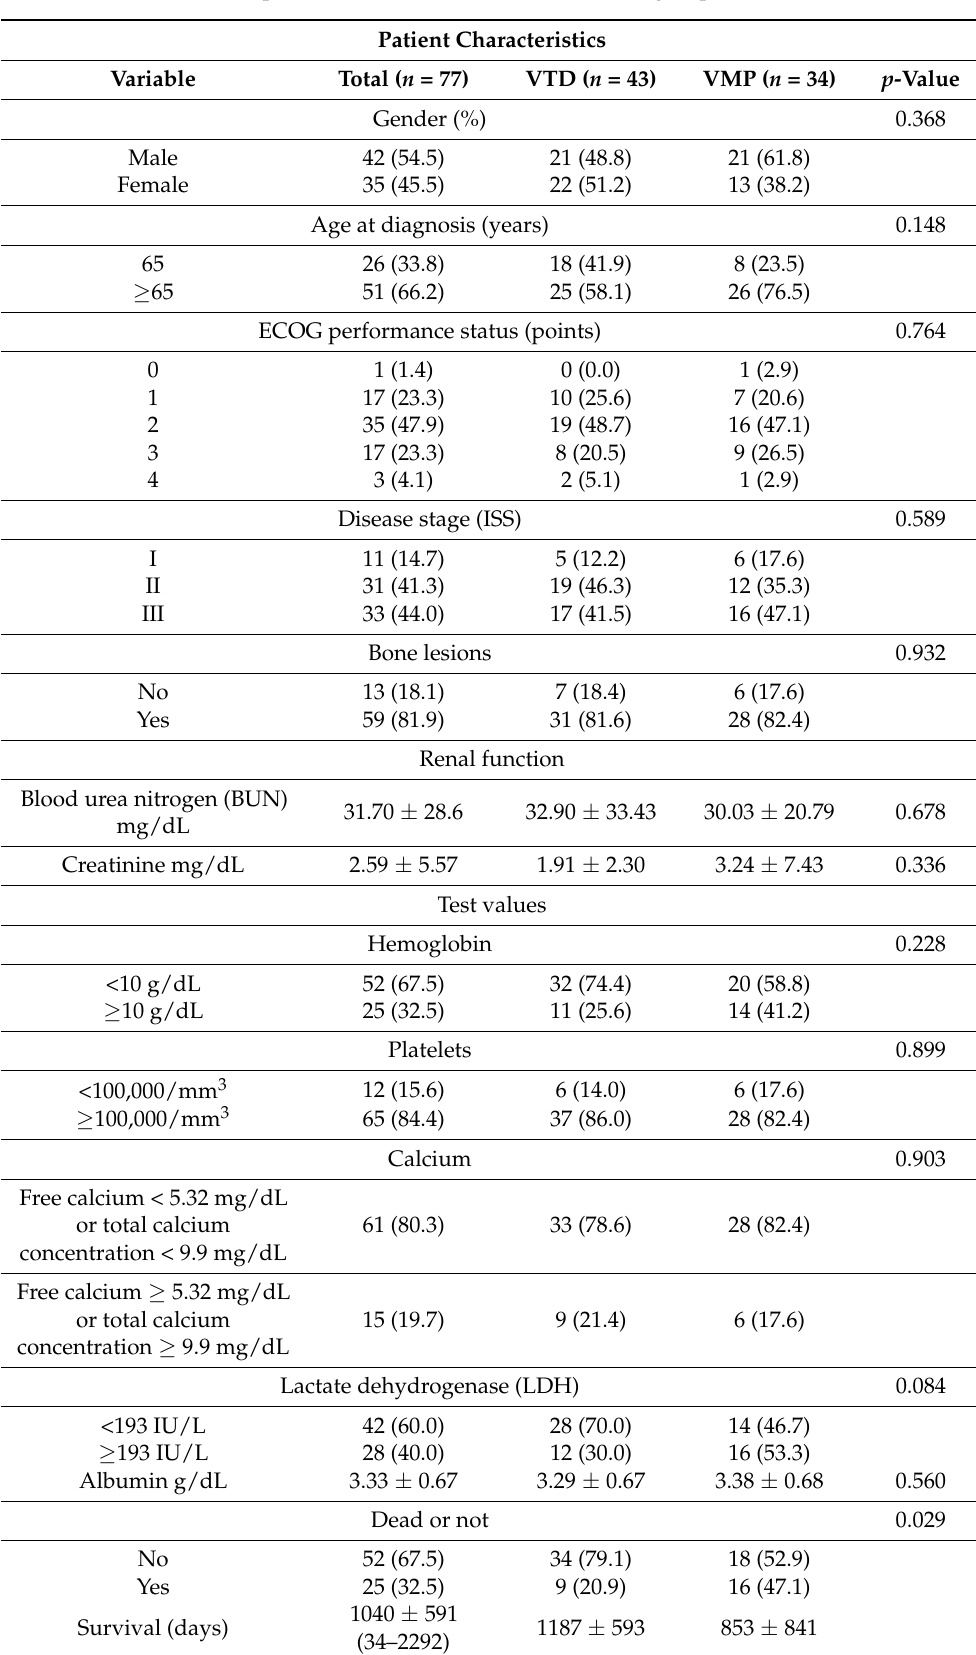
Table 2. Characteristics of patients with VTD and VMP treatment